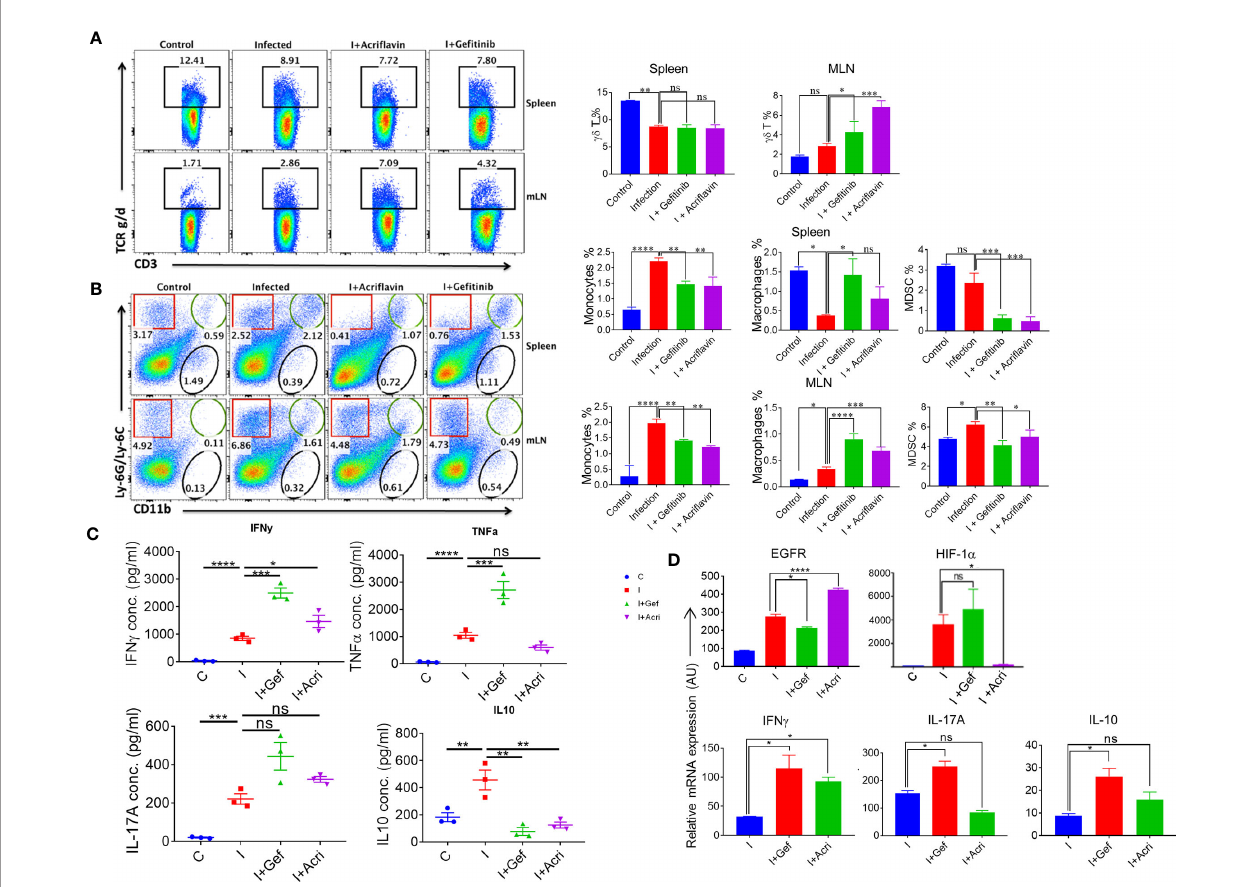
FIGURE 6 | EGFR-HIF1 a axis is essential to promote MDSCs in Salmonella infection. (A, B) Dot plots and bar graphs indicating % frequency of gd T cells, macrophages, MDSCs, monocytes in spleen and MLN in mice infected with S. Typhimurium (n=3 mice per group), analyzed using Flowjo. (C) Graph showing the concentration of different pro and anti-in fl ammatory cytokine (IFN- g , TNF- a , IL-17a, IL-10) in the blood serum (n=3), data representative of triplicates *P < 0.05, **P < 0.01, ***P < 0.001, ****P < 0.0001 (one way ANOVA). (D) Bar graph for mRNA expression of EGFR, HIF1 a , IFN g , IL17A, and IL10 in the MLN cells, data representative of triplicates *P < 0.05, **P < 0.01, ***P < 0.001, ****P < 0.0001 a-d. one way